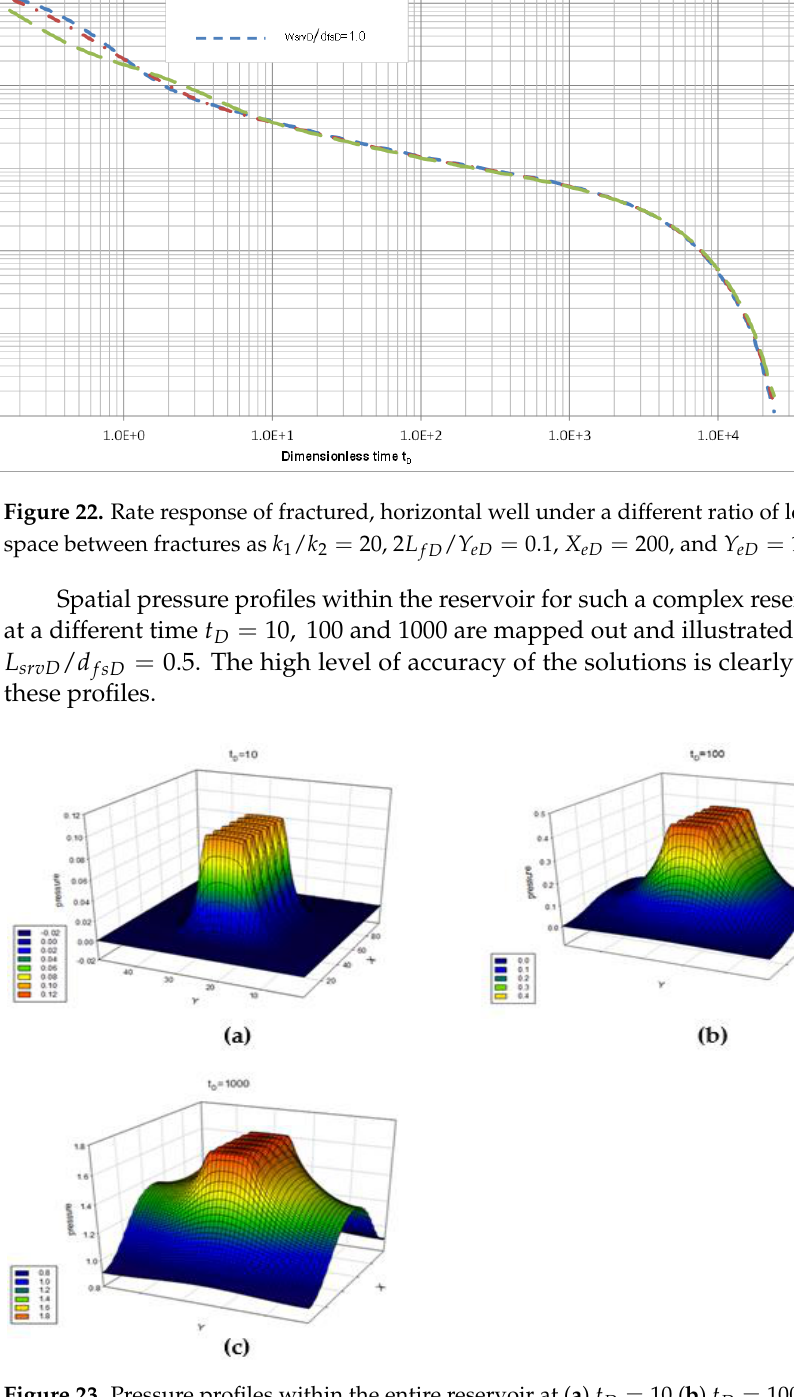
Figure 23. Pressure profiles within the entire reservoir at ( a ) 𝑡 𝐷 = 10 ( b ) 𝑡 𝐷 = 100 ( c ) 𝑡 𝐷 = 1000 with 𝑤 𝑠𝑟𝑣𝐷 /𝑑 𝑓𝑠𝐷 = 0.5 , 2𝐿 𝑓𝐷 /𝑌 𝑒𝐷 = 0.2 and 𝑘 1 /𝑘 2 = 20 , 𝑋 𝑒𝐷 = 200 , and 𝑌 𝑒𝐷 = 100 .